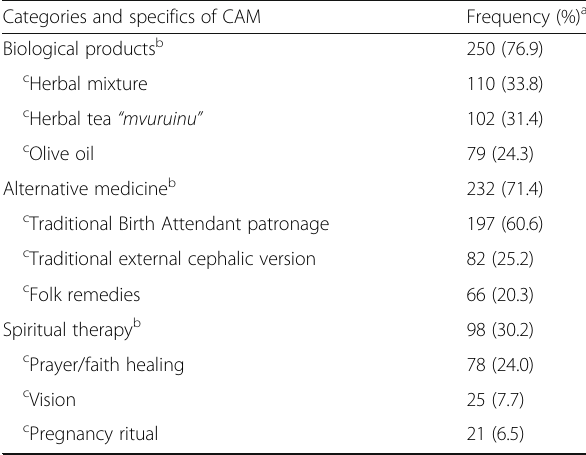
Table 4 Categories and specifics under the categories of CAM